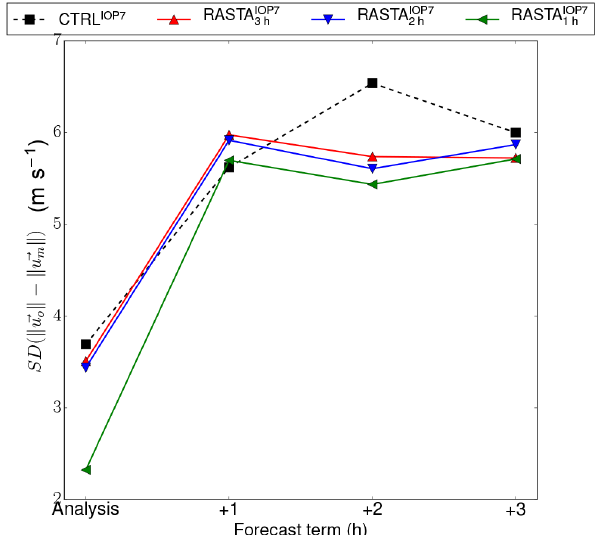
Figure 7. Standard deviation of the wind differences between RASTA observations and each experiment (see legend) as a func- tion of the forecast term from the 06:00UTC analysis on 26 Septem- ber 2012